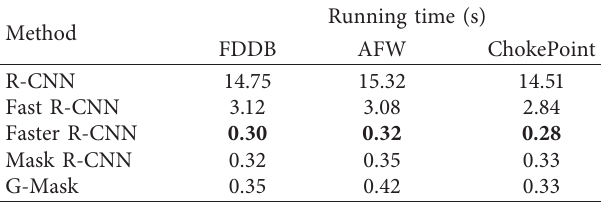
Table 1: Running time of different region-based